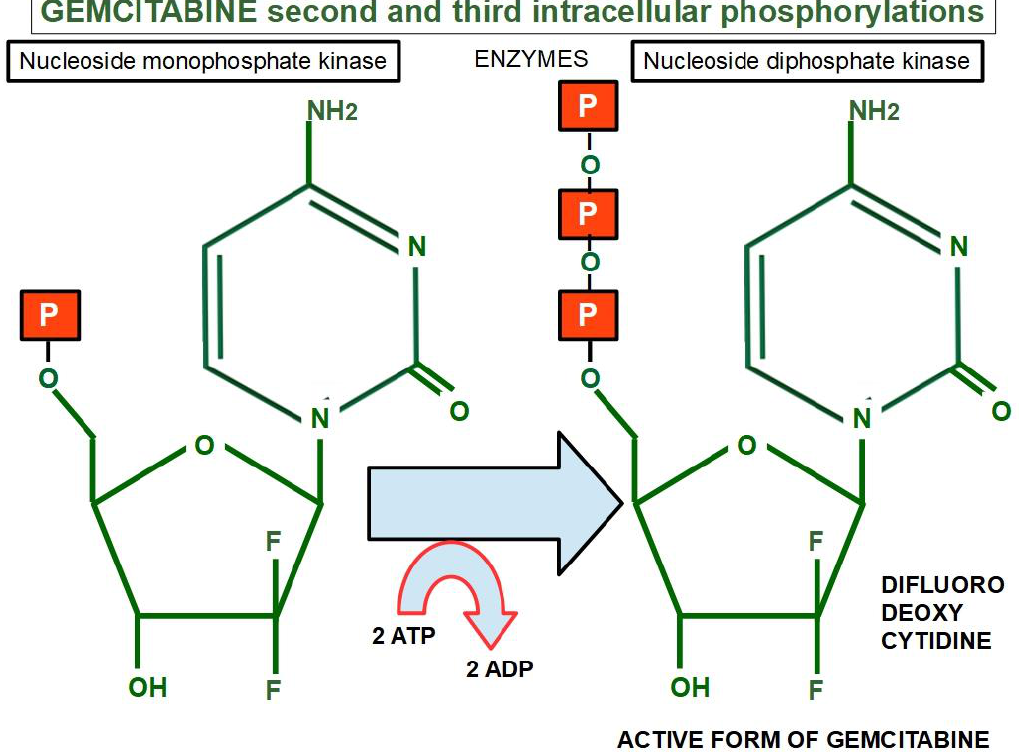
Figure 5. Second and third phosphorylations of gemcitabine by the nucleoside monophosphate kinase and nucleoside diphosphate kinase respectively, rendering the active form: difluoro deox- ycytidine.